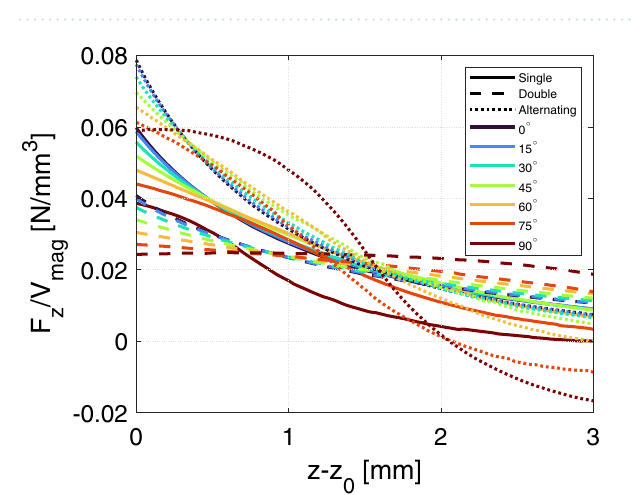
Figure 4. ( a ) The rotor radius, R rotor , at which the volume normalized force, F z / V mag , at z − z 0 = 0 mm is largest, ( b ) the largest force at the optimal rotor radius, for the different bearing geometries and tilt angles considered.